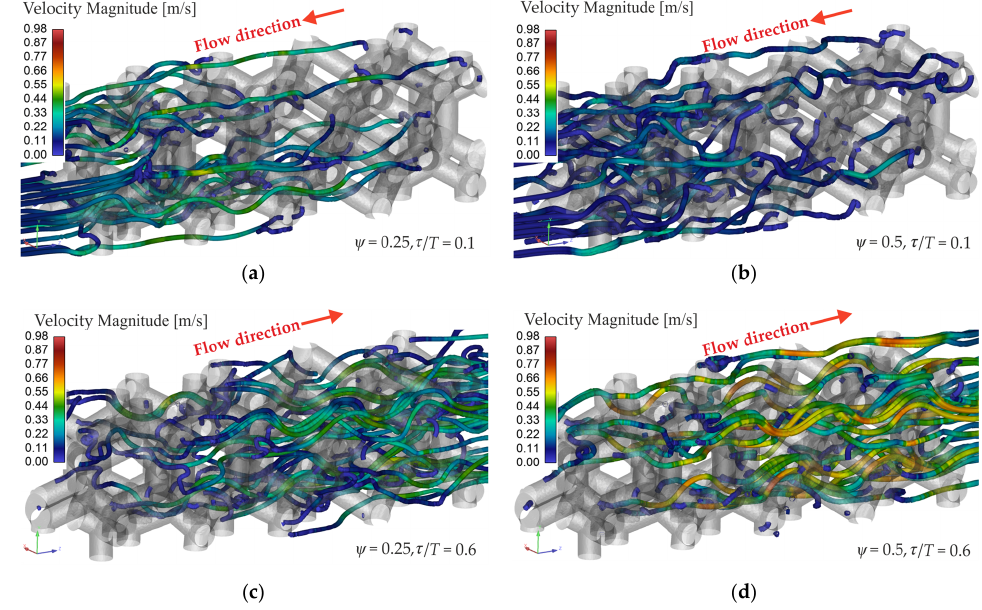
Figure 12. The instantaneous velocity streamlines for pulsating flow at ε = 0.743, Re = 25, ( A / D ) St = 0.344. Unit is m/s: ( a ) ψ = 0.25, τ / T = 0; ( b ) ψ = 0.5, τ / T = 0; ( c ) ψ = 0.25, τ / T = 0.1; ( d ) ψ = 0.5, τ / T = 0.1.